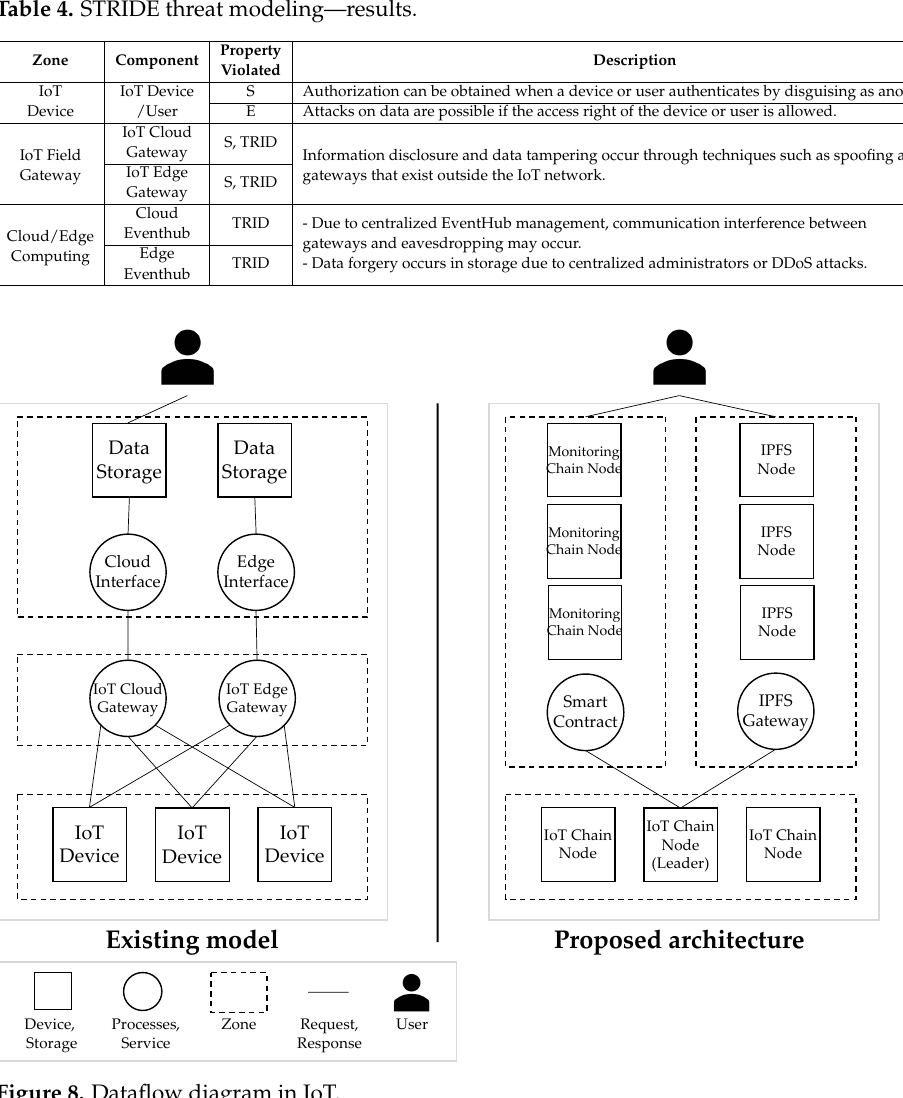
Figure 8. Dataflow diagram in